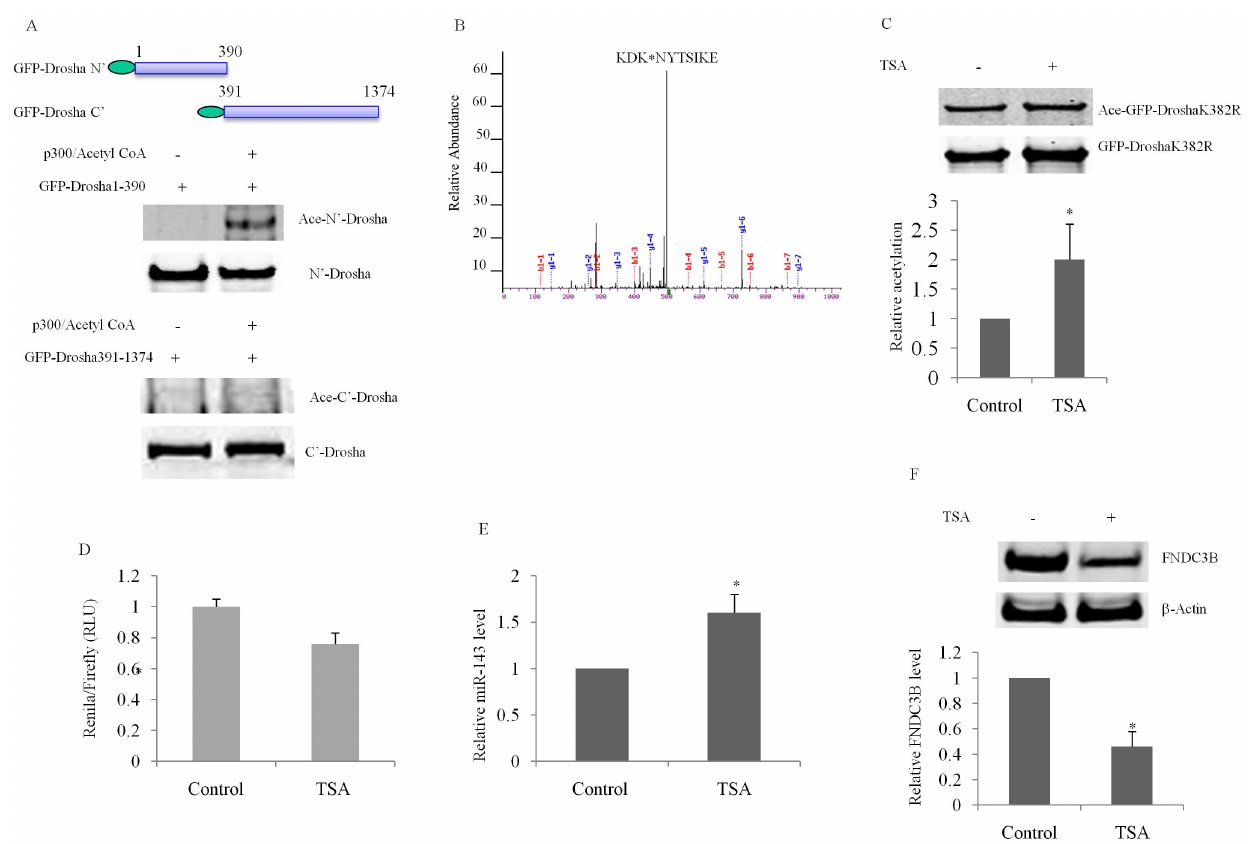
Figure 2. N-terminus of Drosha is the main part for acetylation. ( A ) In vitro acetylation assays revealed that N’-terminal but not C’-terminal Drosha is the major acetylation domain. Immunoprecipitated N-terminal Drosha (GFP-Drosha1-390 ) or C-terminal Drosha (GFP-Drosha391-1374) was co-incubated with 10 U of p300 HAT Domain and 2 m M Acetyl CoA at 37 u C for I hr. ( B ) Identification of an acetylated lysine site by mass spectrometry. (C) TSA treatment increases the acetylation and expression levels of GFP-DroshaK382R (D) miRNA sensor assays revealed that compared to vehicle control, treatment of cells with TSA increased miRNA function. (E) TSA treatment increases miR-143 level in HEK293T cells. (F) TSA treatment decreases expression of fibronectin type III domain containing 3B (FNDC3B), a target of miR-143. All experiments were performed in triplicate (p , 0.05 by Student’s t-test).